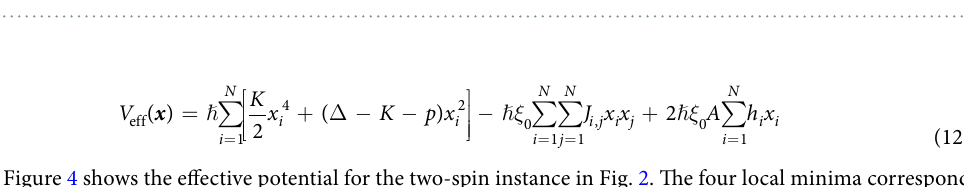
Figure 4. Effective potential. ( a–c ) The effective potentials defined by Eq. (12) with p K 3 = , 4 K , and 5 K , respectively, for the instance of the two-spin Ising model in Figs 1 and